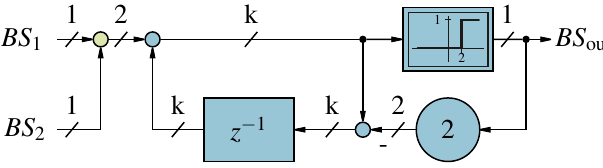
Figure 6. Equivalent control scheme for Delta Adder [11].